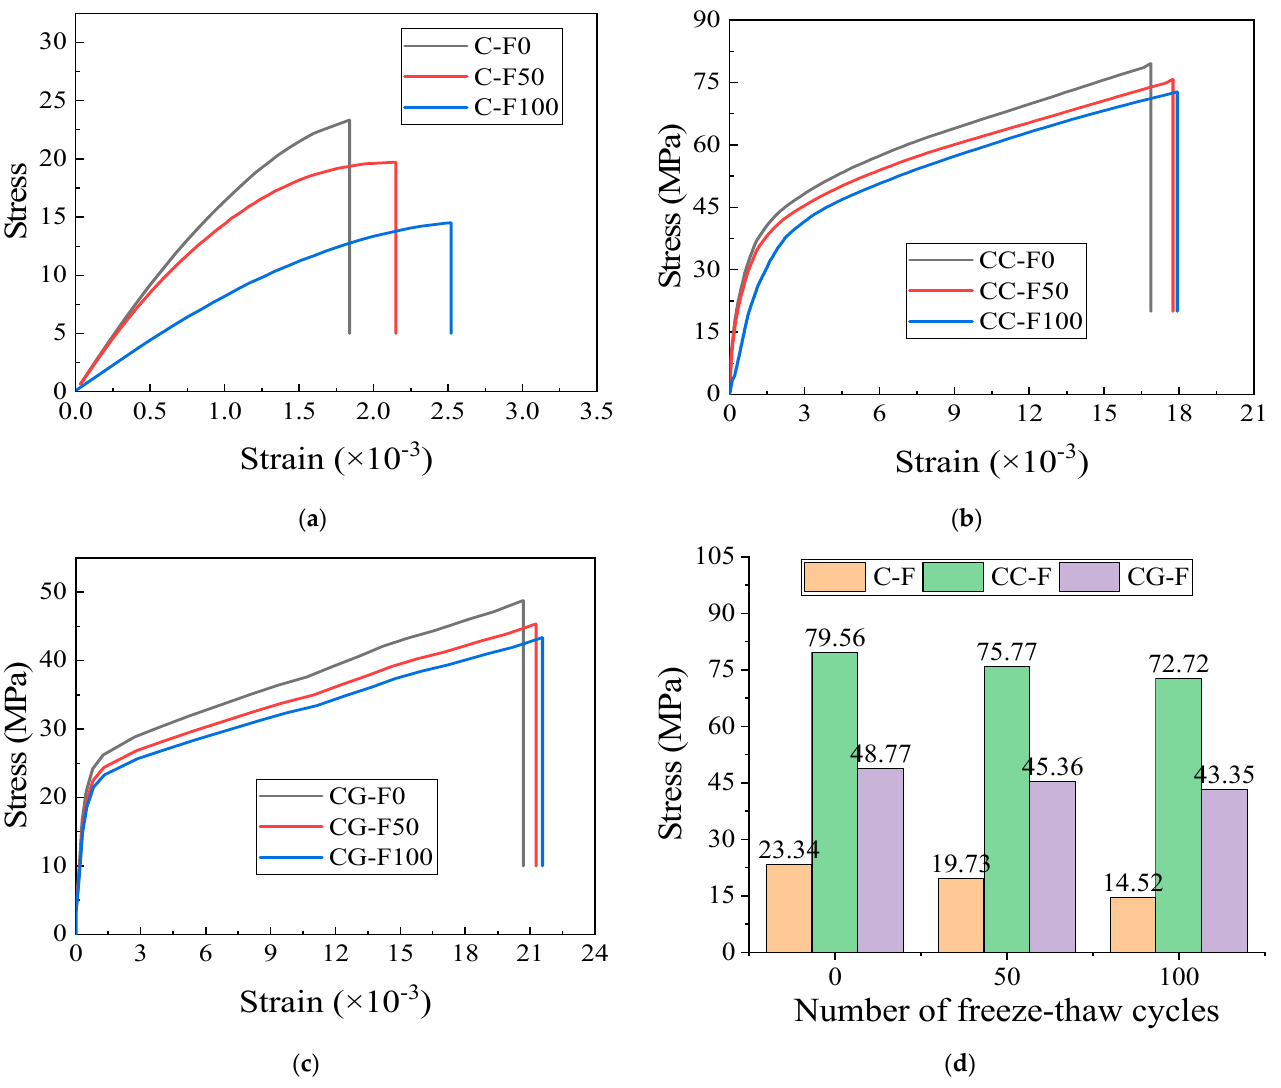
Figure 10. Compressive stress–strain curves of cylindrical specimens: ( a ) unreinforced cylinder; ( b ) carbon-fiber-strengthened cylinder; ( c ) glass-fiber-strengthened cylinder; ( d ) stress variation